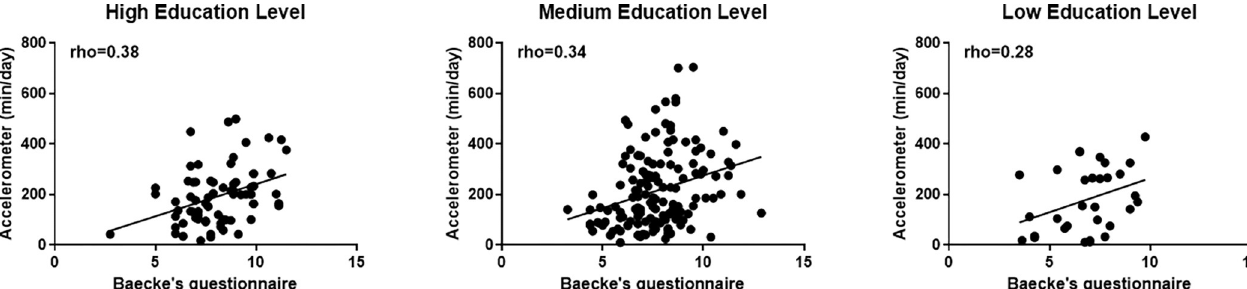
Fig 1. Correlation between Baecke questionnaire and physical activity assessed by